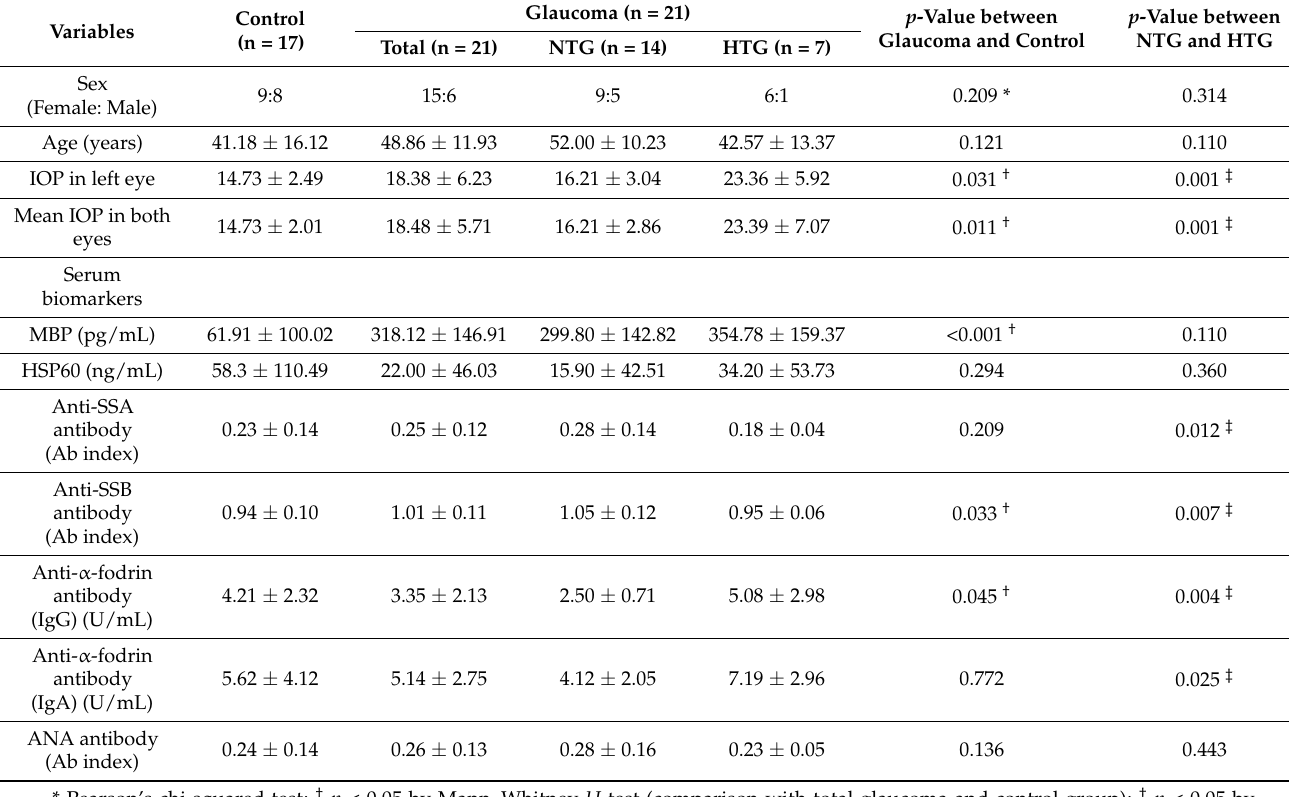
Table 1. Serum antibody levels measured by enzyme-linked immunosorbent assay